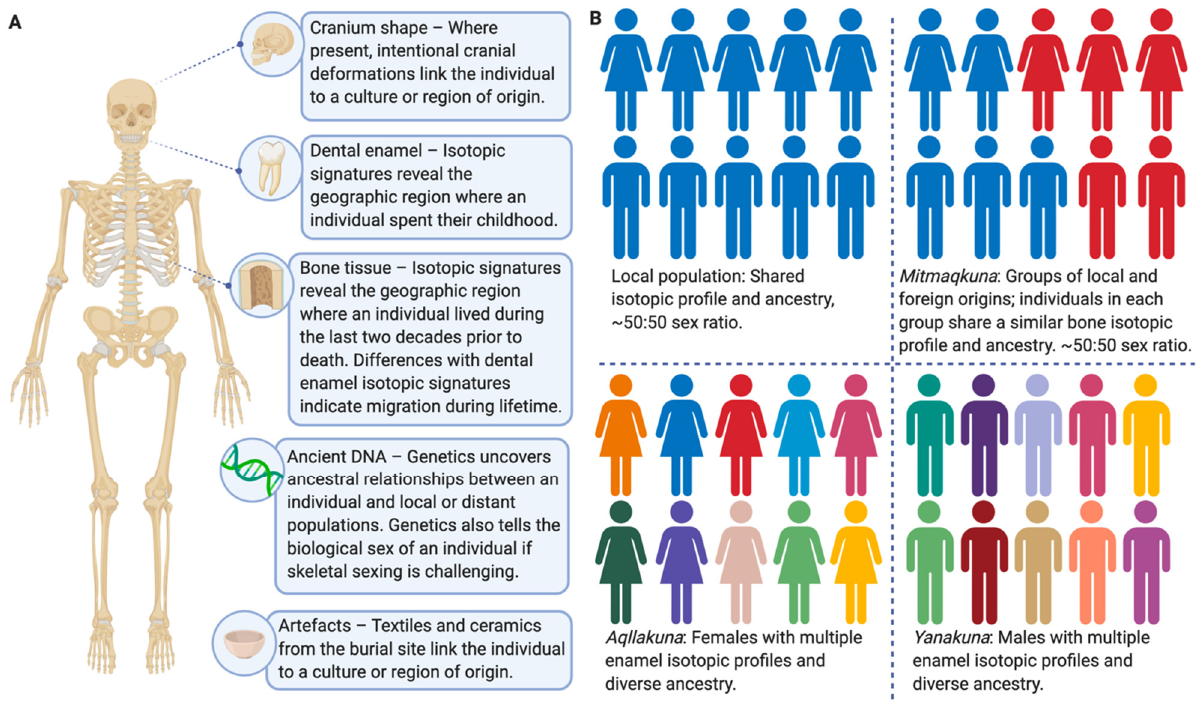
Figure 3. Schematic summary of evidence that could be combined from multiple disciplines to comprehensively address the Inka resettlement policy. ( A ) Evidence that could potentially be obtained from a buried individual. We strongly advocate merging multiple lines of evidence into an interdisciplinary framework. ( B ) Possible demographies of a hypothetical buried population. Individuals from a local population with no migration cluster together genetically, show no indication of migration during their lifetime, and a ~50:50 sex ratio is observed. Mitmaqkuna would be indicated by a significant proportion of individuals with isotopic evidence of during-life migration and shared ancestry distinct from the local population, and a ~50:50 sex ratio is expected. Groups of buried females or males with multiple isotopic profiles from enamel (early life) and diverse ancestry are likely to be aqllakuna or yanakuna , respectively. Created with BioRender.com (accessed on 2 February